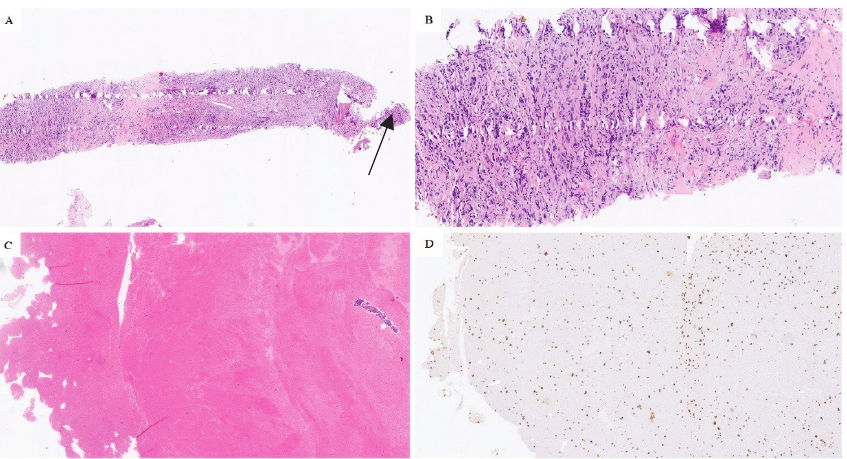
Figure 2. Optimal tumor quantity in a bone biopsy specimen, hematoxylin and eosin staining, magnification 20 × ( A ). Note small osseous fragment (arrow). Higher-power view of tumor cells, same section, magnification 100 × ( B ). Suboptimal specimen quality, most of the material is in the form of a clot with scattered tumor cells, hematoxylin and eosin staining, magnification 20 × ( C ). Tumor cells were apparent only with cytokeratin AE1/AE3 staining, magnification 20 × ( D